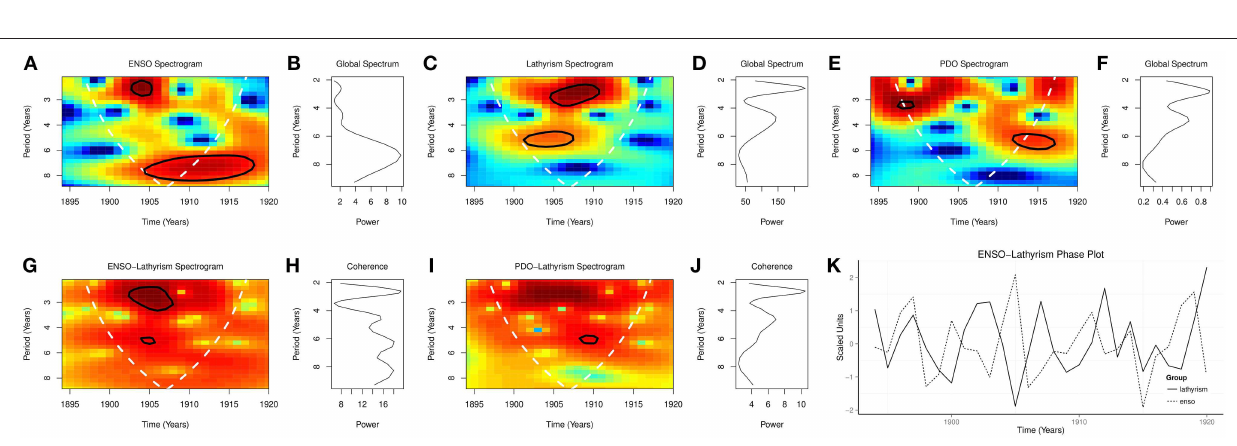
and 7.0 years for ENSO, and at 2.7, and 5.0 years for